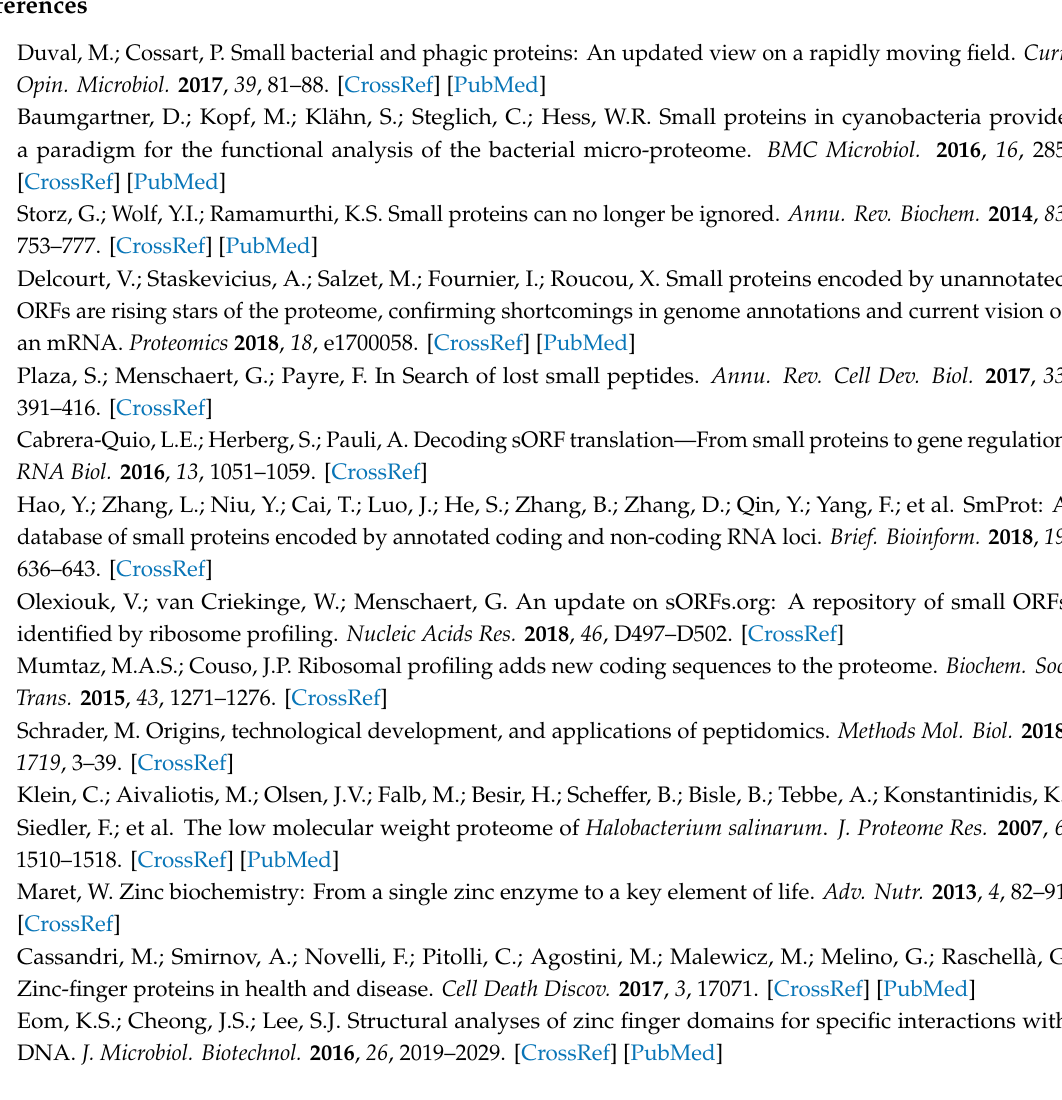
Table S1: List of primers used for the generation of deletion mutants. Table S2: Overview of characteristics of the analyzed 16 zinc finger proteins. Figures S1–S4: Growth in synthetic medium with casamino acids, growth with genomic DNA as phosphate source, growth in the presence of 0.030 mg / mL and 0.035 mg / mL bile